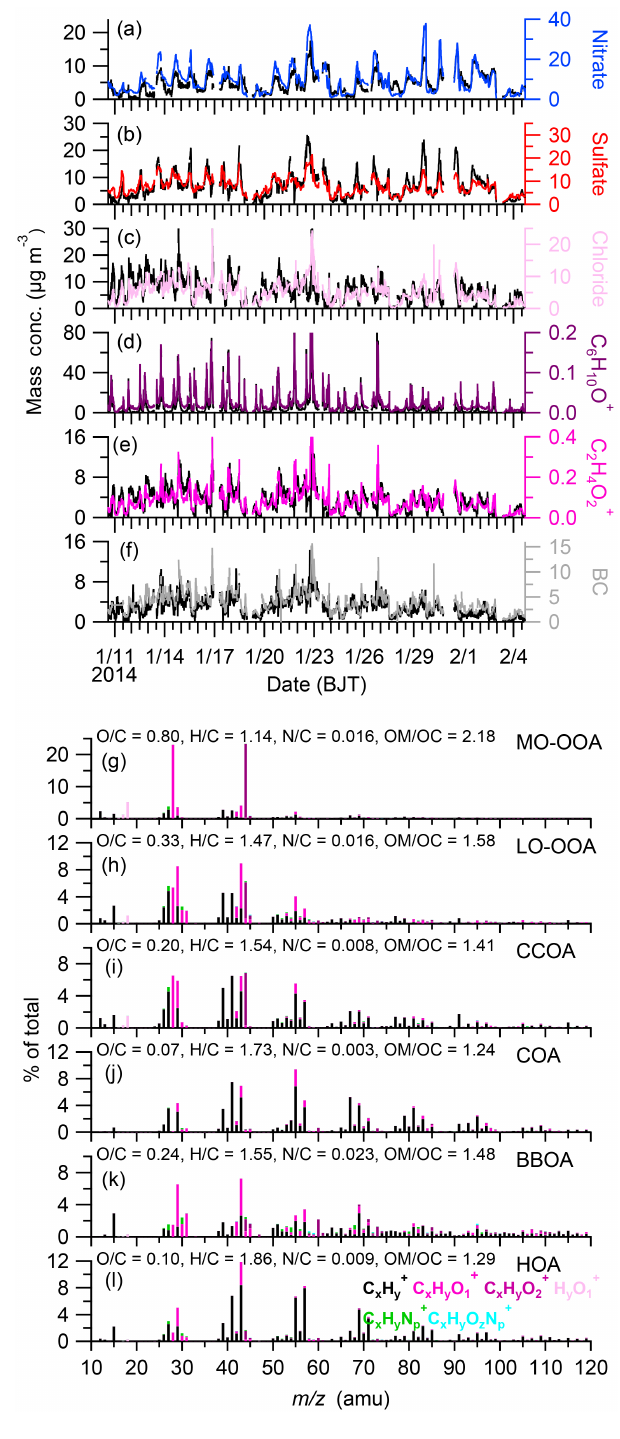
Figure 7. The PMF results of time series ( a – f ) and HR-MS ( g – l ) for each component. The temporal variations of different tracers are also present to support each component.